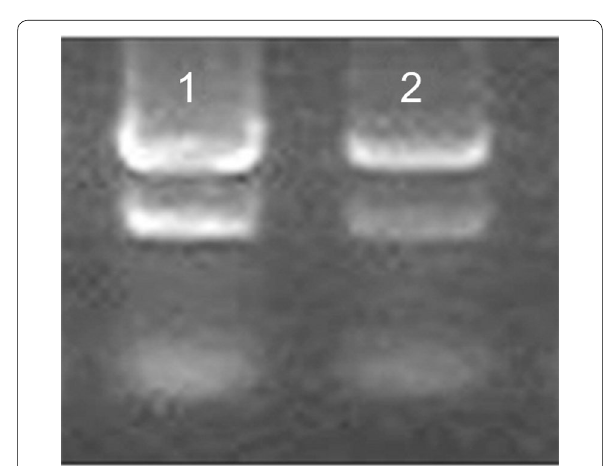
Fig. 8 Total RNA in mouse spleen lymphocytes. 1: 0.9% NaCl, 2: MIPs